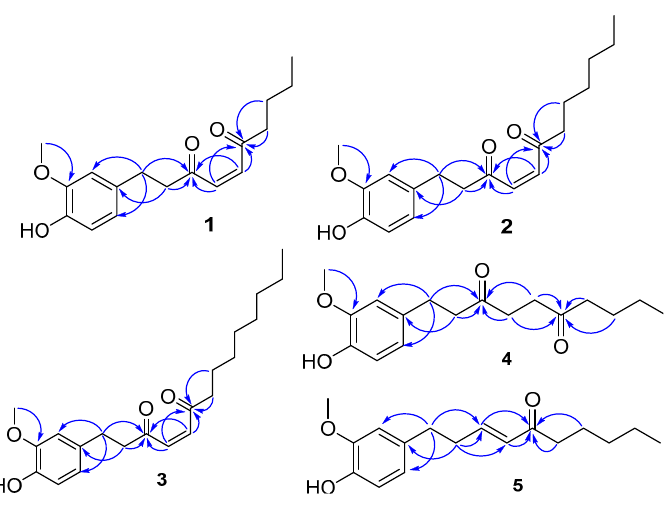
Figure 2. Key HMBC correlations of compounds 1 – 5 . Table 1. 1 H- (500 MHz) and 13 C-NMR (125 MHz) data for compounds 1 – 4 in CDCl 3 ( δ in ppm, J in Hz).